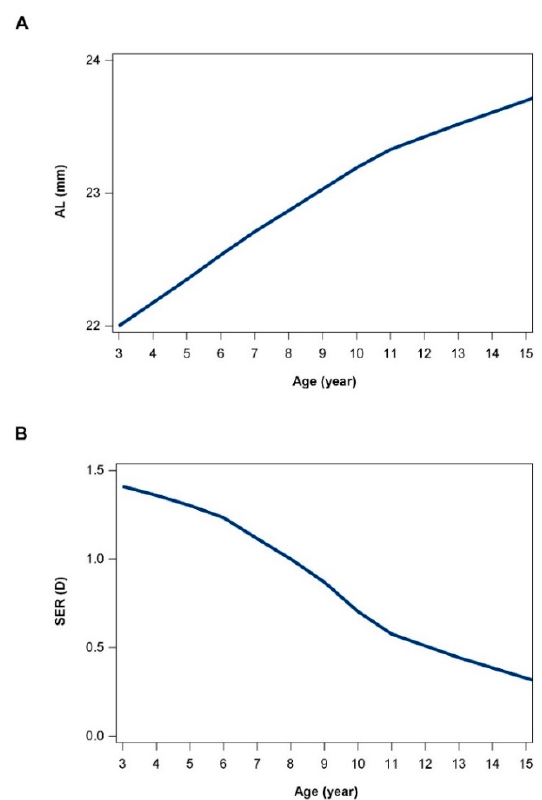
Figure 2. Axial length (AL) and spherical equivalent refraction (SER) change from 3 to 15 years of age. ( A ) The change in AL. ( B ) The change in SER. Data were plotted pooling all the participants with two-year follow-up. The current data were interpreted as longitudinal data with minimal cohort effect.